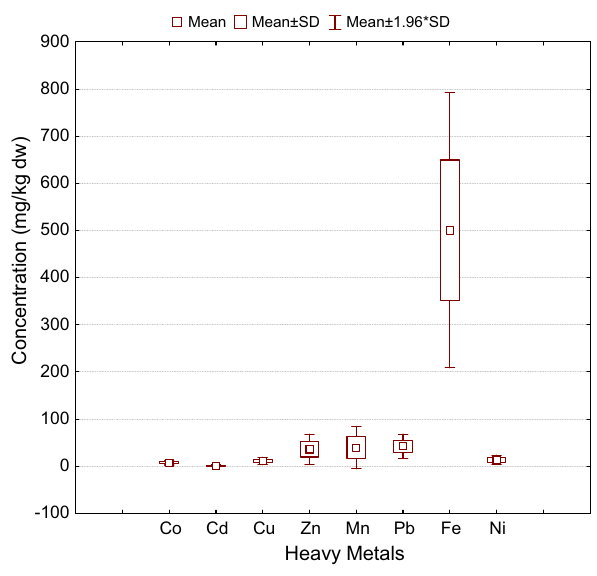
Fig. 2 Box and whisker plot showing variation in heavy metals con- centrations in sediment